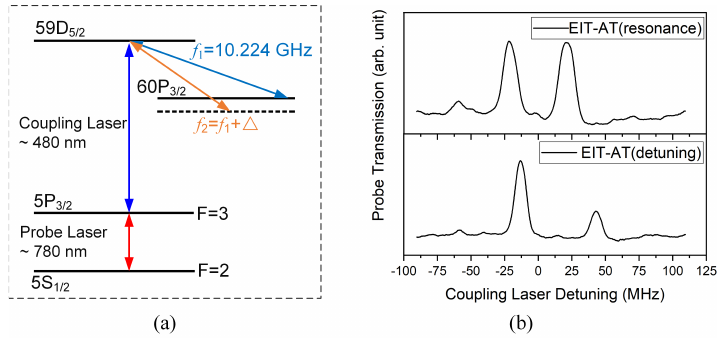
Figure 2. ( a ) Experiment-related energy levels. ( b ) RF-induced symmetric or asymmetric Autler– Townes